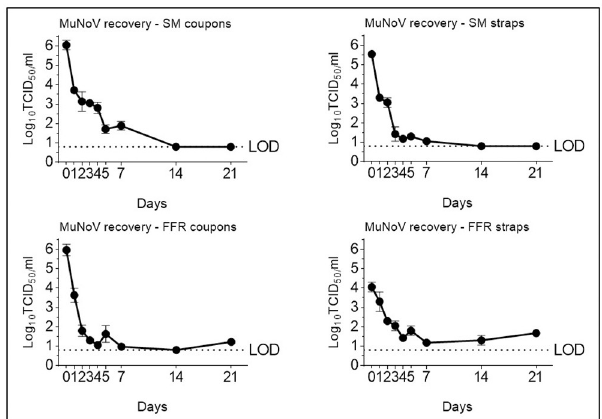
Fig 3. Recovery of murine norovirus (MuNoV) after elution from filtering facepiece respirators (FFRs) and surgical masks (SMs) kept at room temperature (20˚C) over time. MuNoV infectivity was analysed in RAW264.7 cells. The cell culture limit of detection (LOD) was 0.80 log10 TCID 50 /mL (6.31 × 10 0 TCID 50